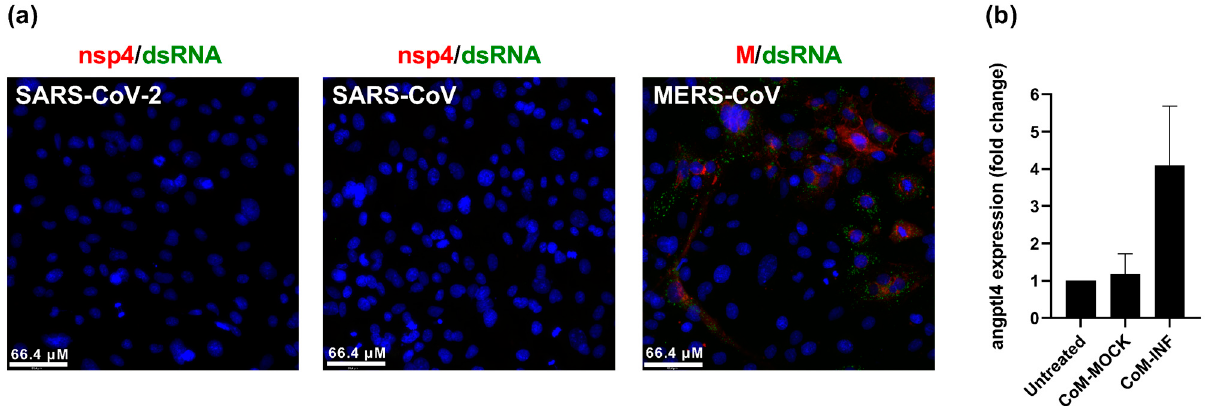
Figure 1. Infection of Hulec-5a lung endothelial cells with various coronaviruses and expression of angiogenic factor angptl4. ( a ) Hulec-5a cells were infected with SARS-CoV-2, SARS-CoV, and MERS-CoV (multiplicity of infection (MOI) 5), and after 48 h, the cells were fixed and stained with rabbit polyclonal anti-SARS-CoV nsp4 protein antibody for SARS-CoV-2 and SARS-CoV, rabbit polyclonal anti-MERS-CoV M protein antibody for MERS-CoV, mouse monoclonal anti-dsRNA antibody (J2), and Hoechst, and visualized by immunofluorescence microscopy. Images are representative of results from 3 independent experiments. ( b ) Hulec-5a cells were incubated with conditioned medium from uninfected (CoM-MOCK) or infected (CoM-INF) Calu-3 lung epithelial cells for 24 h (diluted 1:2 with endothelial cell medium). Intracellular RNA was isolated to quantify angptl4 expression by RT-qPCR, using PGK1 as a reference gene. Changes in angptl4 expression were normalized to untreated Hulec-5a cells (Untreated). The mean ± SEM of 3 independent experiments is shown.